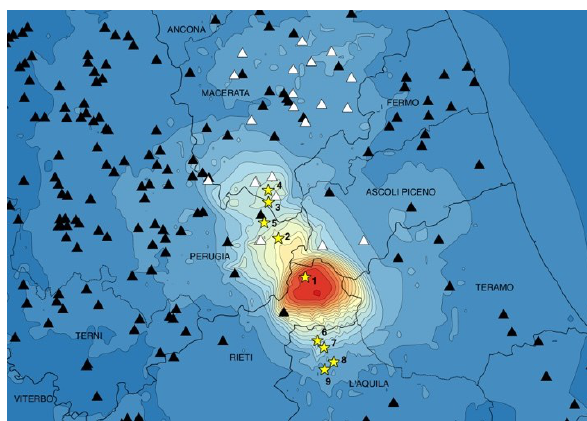
Figure 5. Shakemap (pga) of Central Italy (first seismic event in Tab. 1) with fortified buildings. The damaged buildings are white and epicentres are represented with stars.